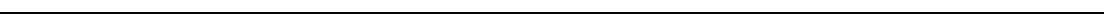
Fig. 3 Dim2 interacts with Utp14, an activator of Dhr1 helicase. a 2-hybrid interaction between Dim2 and Utp14. Yeast 2-hybrid analysis of three individual transformants, harboring the indicated bait (BD) and prey (AD) plasmids. Transformants were analyzed by growth on SDC-Leu-Trp (plating ef fi ciency) and SDC-Leu-Trp-Ade plates (strong interaction). SV40 and p53 served as negative controls. The growth was analyzed after 2 days at 30 °C. b Reconstitution of ct Dim2-Utp1-Utp14-Dhr1 complexes. The indicated dimeric ct Dim2-Utp14 and trimeric ct Dim2-Utp1-Utp14 and ct Dim2-Utp14-Dhr1 complexes using Chaetomium thermophilum proteins were assembled by co-expression in yeast followed by split-tag tandem af fi nity-puri fi cation. The reconstituted complexes were analyzed via SDS-PAGE (4 – 12%) and Coomassie staining. c Yeast strains GAL::scDIM2 with integrated sc Dhr1-FTpA or sc Utp14-FTpA were grown in galactose (GAL) medium or shifted for 8 h to glucose (GLU) containing medium before the indicated bait proteins were tandem af fi nity-puri fi ed in two consecutive steps involving the ProtA — in the fi rst and the Flag-tag in the second step. TCA-precipitated Flag eluates were analyzed by SDS-PAGE (4 – 12%) and Coomassie staining (upper panel) or western blotting (lower panel) using the indicated antibodies. The indicated protein bands were identi fi ed via mass spectrometry. d Final eluates derived from sc Dhr1-FTpA tandem af fi nity-puri fi cation under conditions of Dim2 expression (GAL) and depletion (GLU, 8 h), respectively, were analyzed by sucrose gradient (15 – 40%) centrifugation. Gradient fractions (1 – 14) were TCA-precipitated and analyzed by SDS-PAGE (4 – 12%) and Coomassie staining (upper panels) and western blotting against Dhr1-Flag (lower panels, long and short exposure times are depicted). The experiments were performed at least twice with consistent results. Uncropped images are shown in Supplementary Fig. 9. L